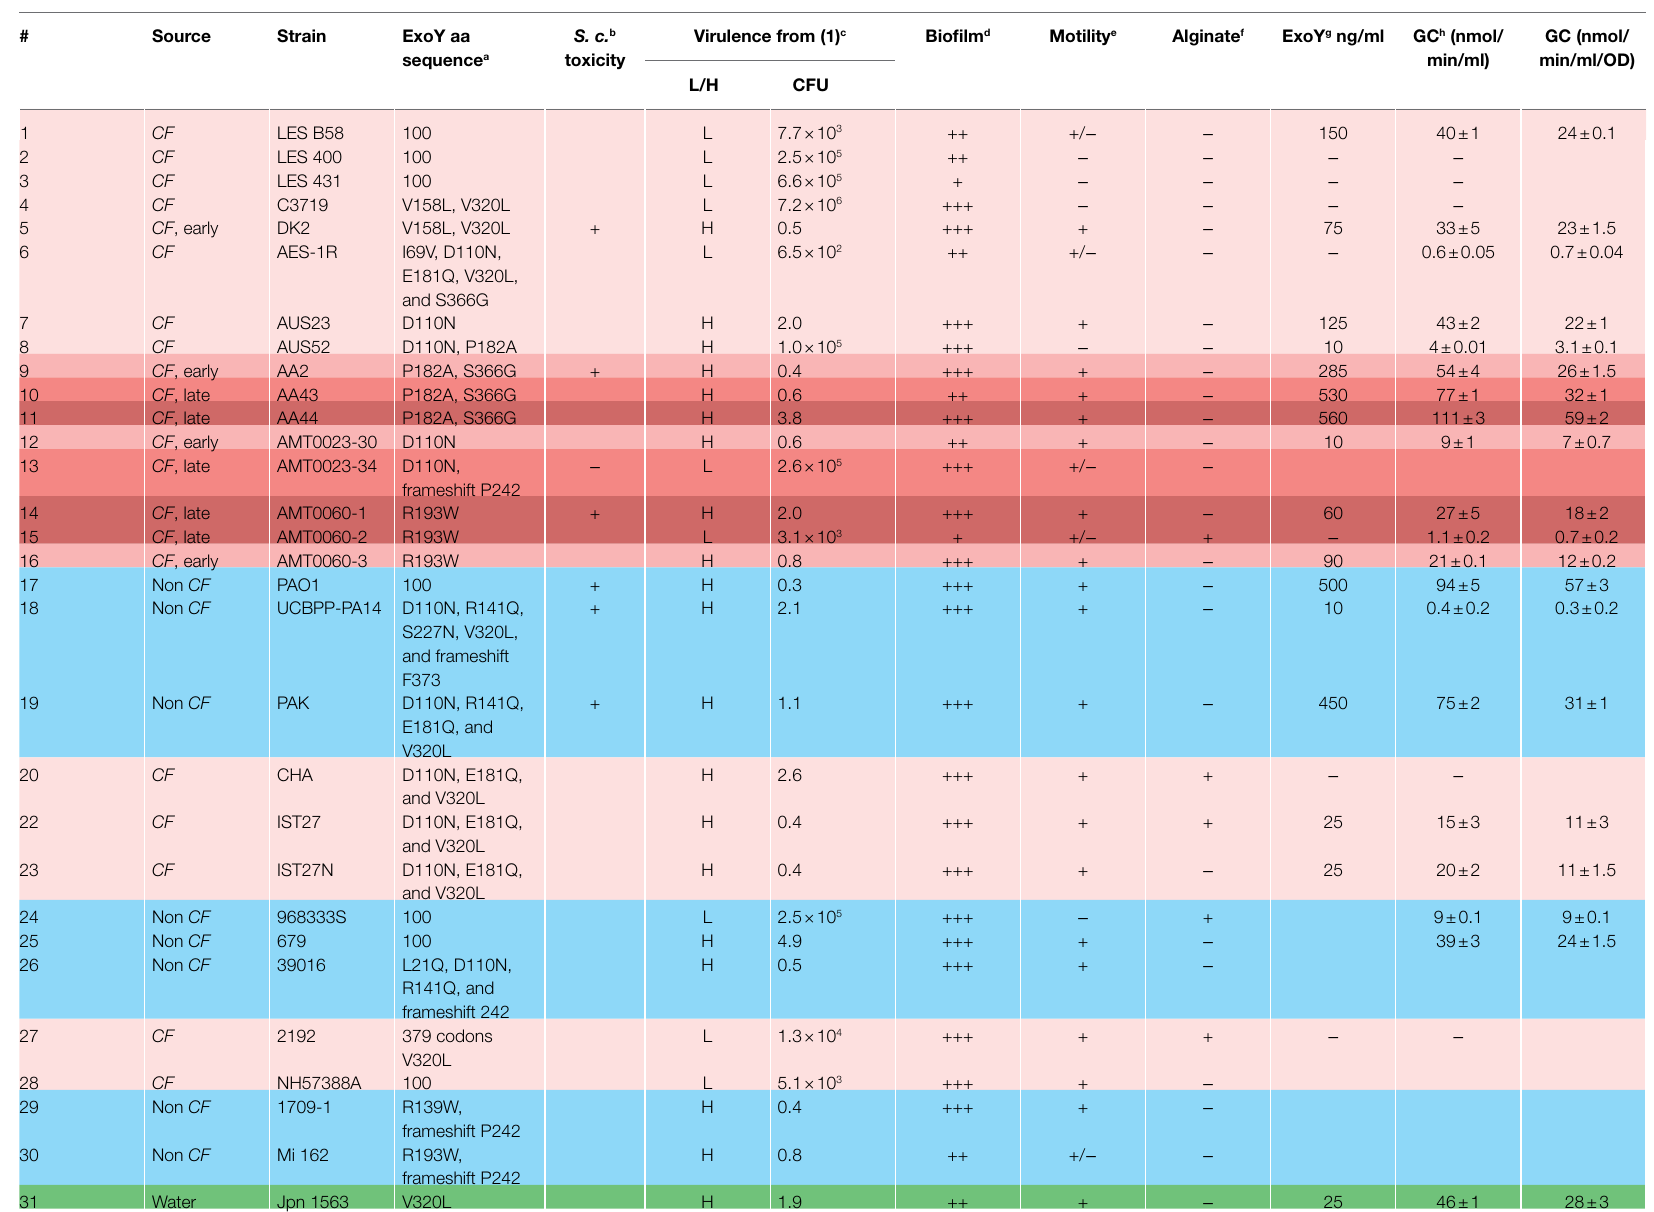
TABLE 2 | ExoY geno-and phenotype in P. aeruginosa reference panel